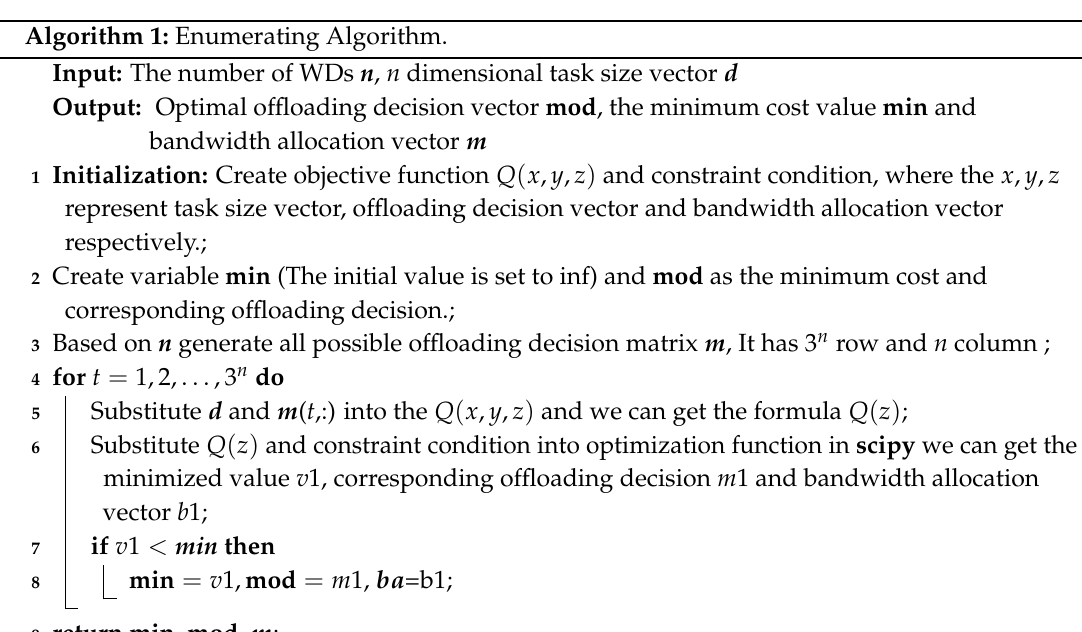
Algorithm 1: Enumerating